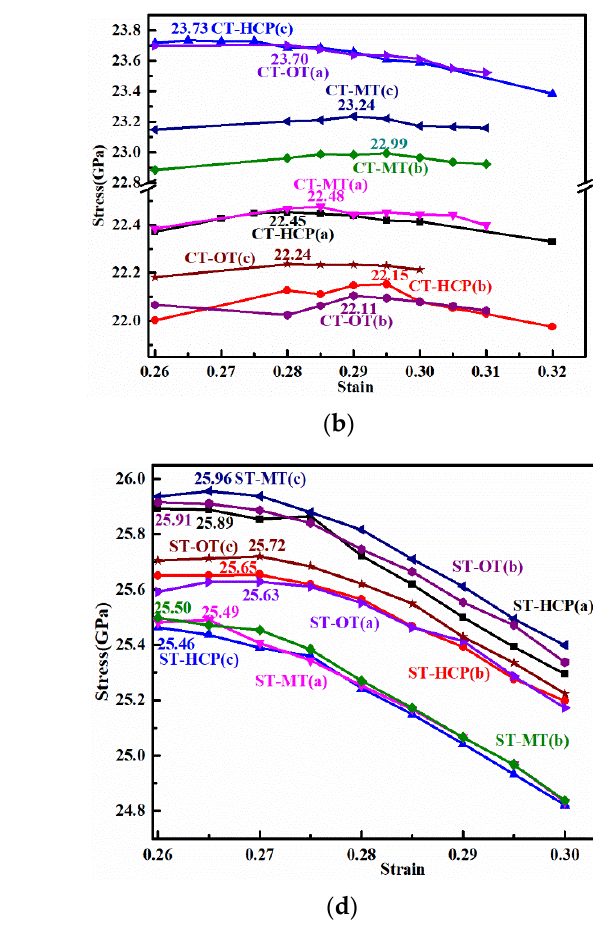
Figure 9. Strain vs. stress of the 6H-SiC(0001)/Cu(111). ( a ) The profiles of tensile stress vs. engi- neering strain of the CT-6H-SiC (0001)/Cu (111), ( b ) partial enlargement of the tensile stress vs. en- gineering strain of the CT-6H-SiC (0001)/Cu (111) around the ultimate tensile strength., ( c ) the pro- files of tensile stress vs. engineering strain of the ST-6H-SiC (0001)/Cu (111), ( d ) partial en-largement of the tensile stress vs. engineering strain of the ST-6H-SiC (0001)/Cu (111) around the ultimate ten- sile